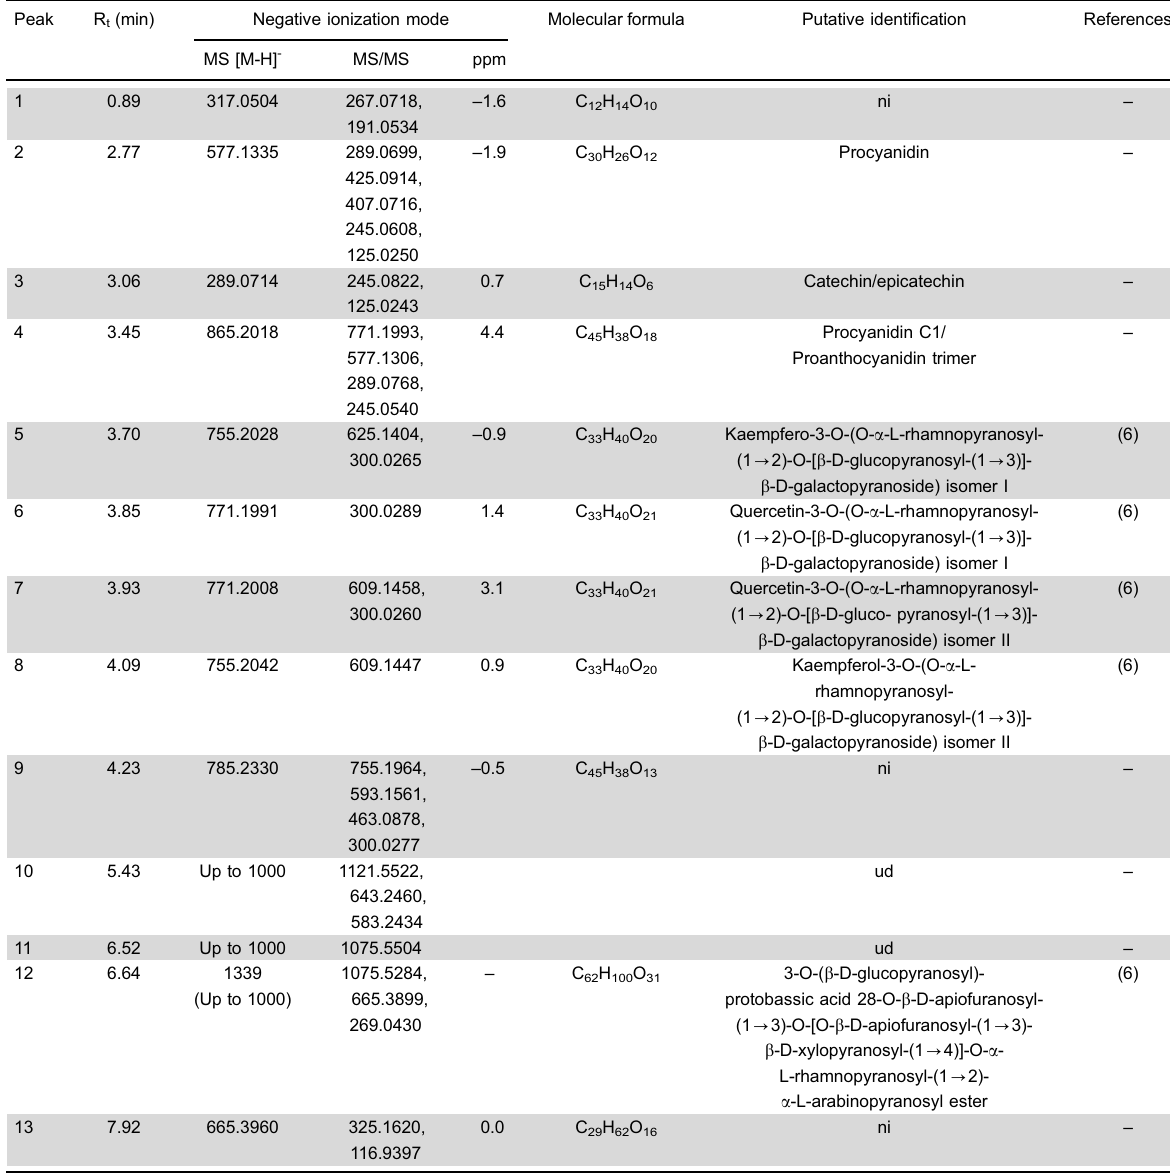
Table 1. Putative identi fi cation of the secondary metabolites present in the methanol fraction from leaf decoction of Sideroxylon obtusifolium . Peak R t